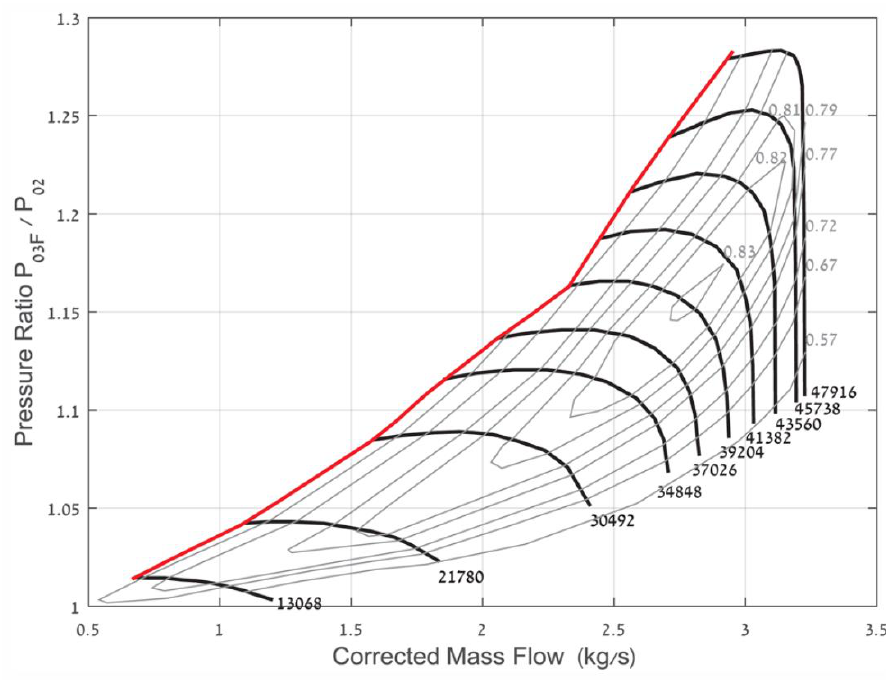
Figure 7. Scaled LPC fan performance map.